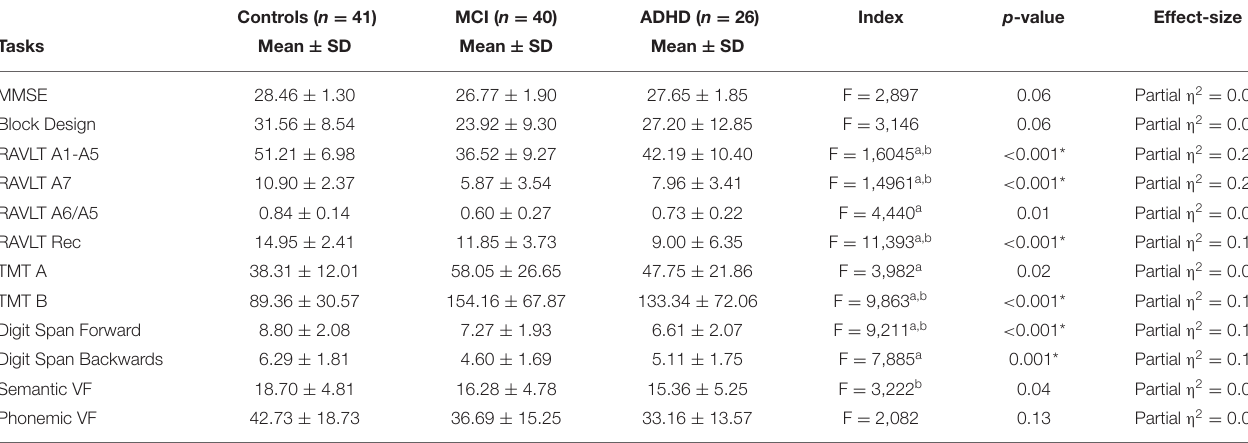
TABLE 2 | Neuropsychological performances across groups with adjustments for age, sex, schooling, and depressive